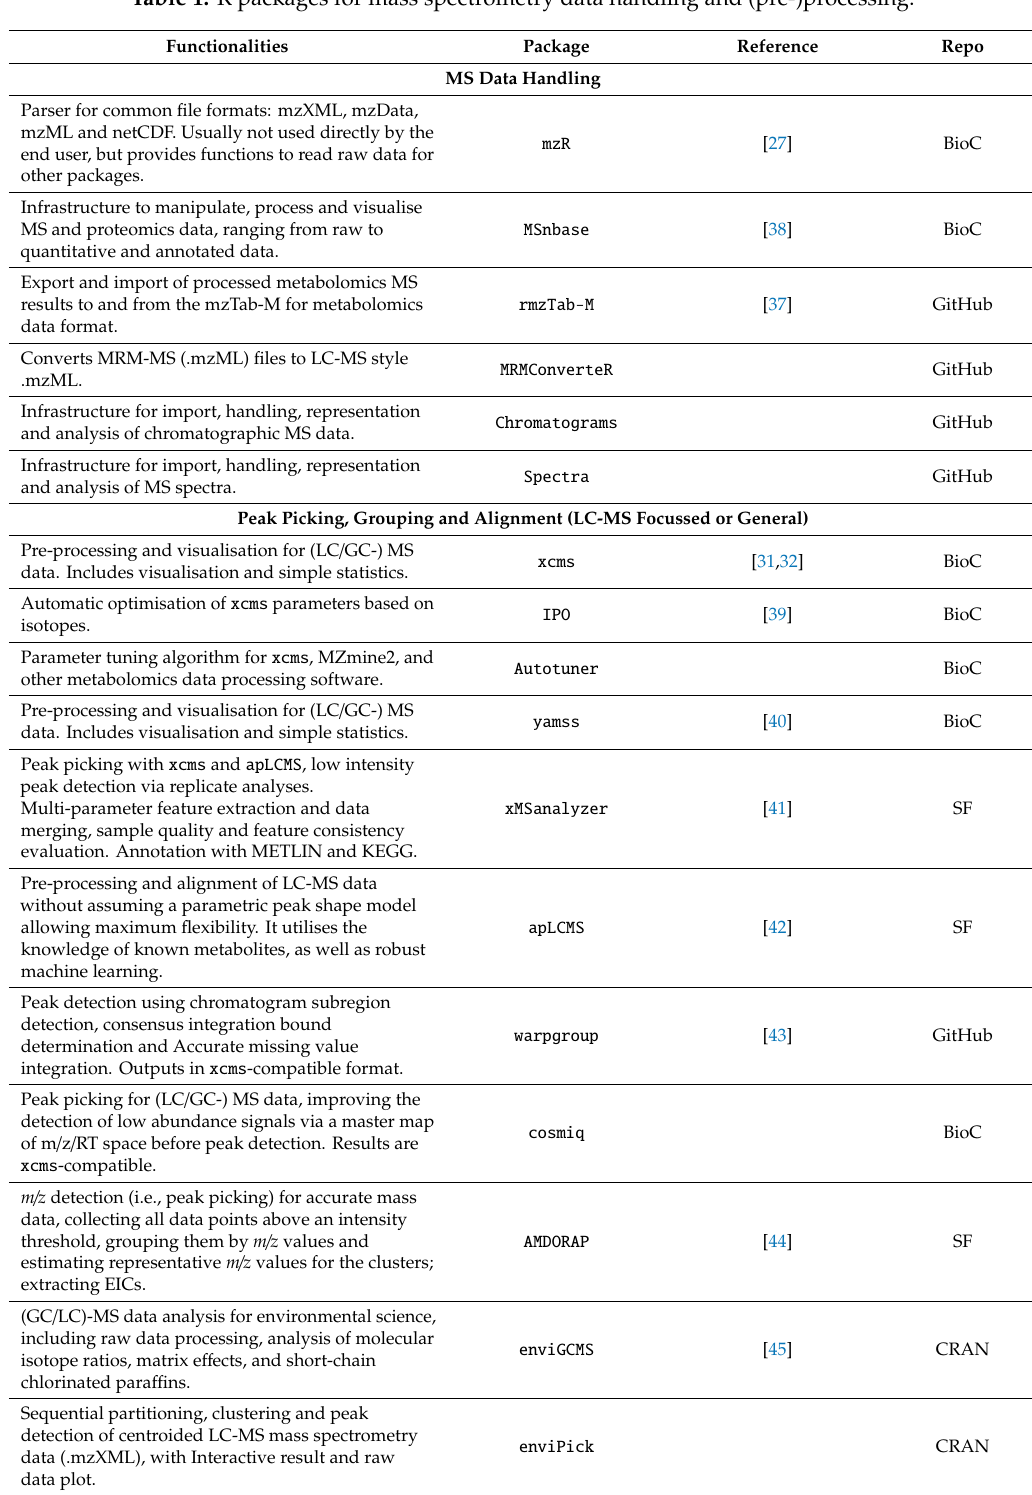
Table 1. R packages for mass spectrometry data handling and